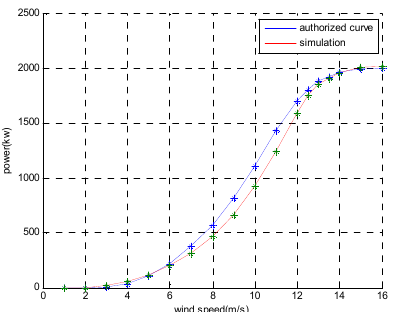
Figure 14. Power curve comparison of the practical wind turbine and the simulation.